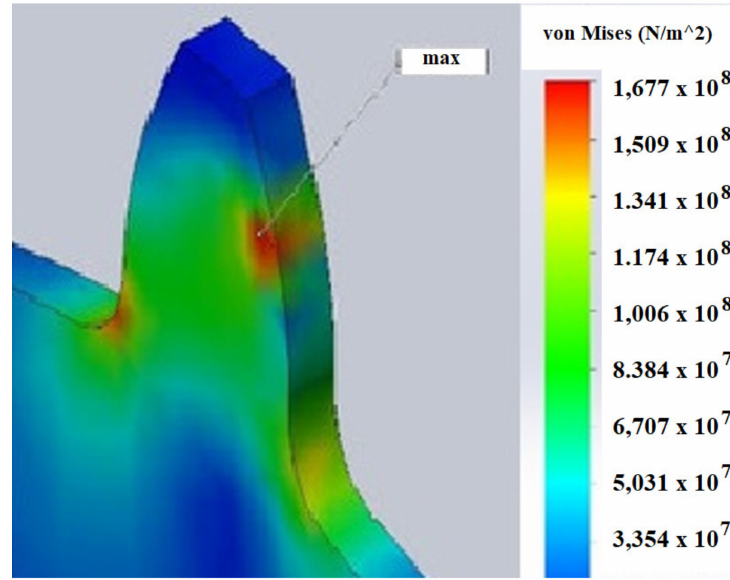
Figure 10. Localization of internal stresses at a given